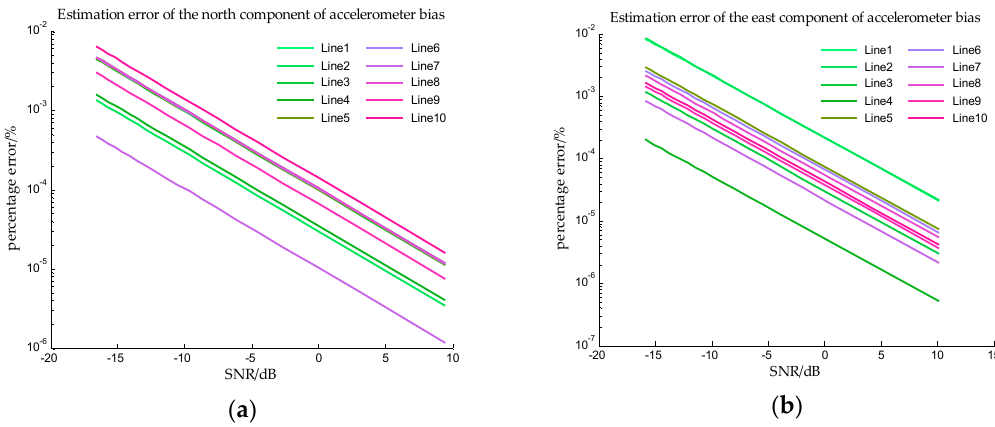
Figure 13. The estimation error of accelerometer bias in simulation II. ( a ) is the estimation error of the north component of the accelerometer bias, and ( b ) is the estimation error of the east component of the accelerometer bias.